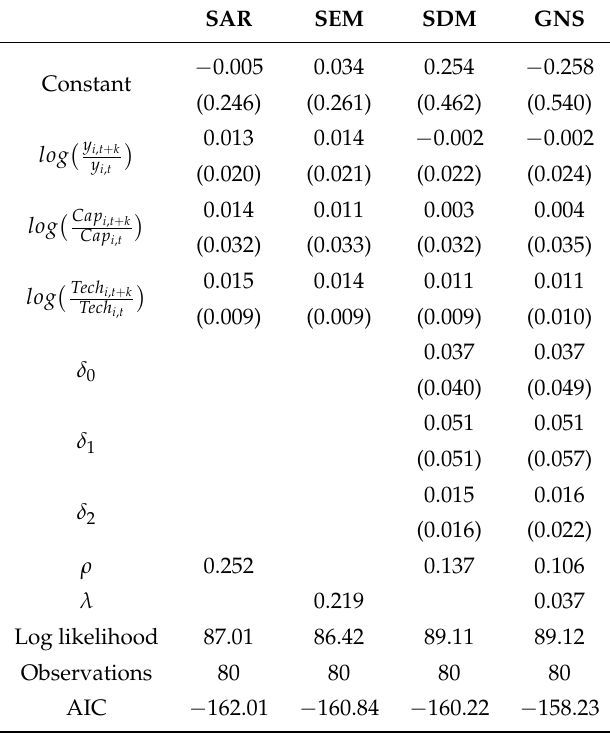
Table 5. Conditional β -convergence models for 2014–2017. The weight matrix is adjacency matrix.